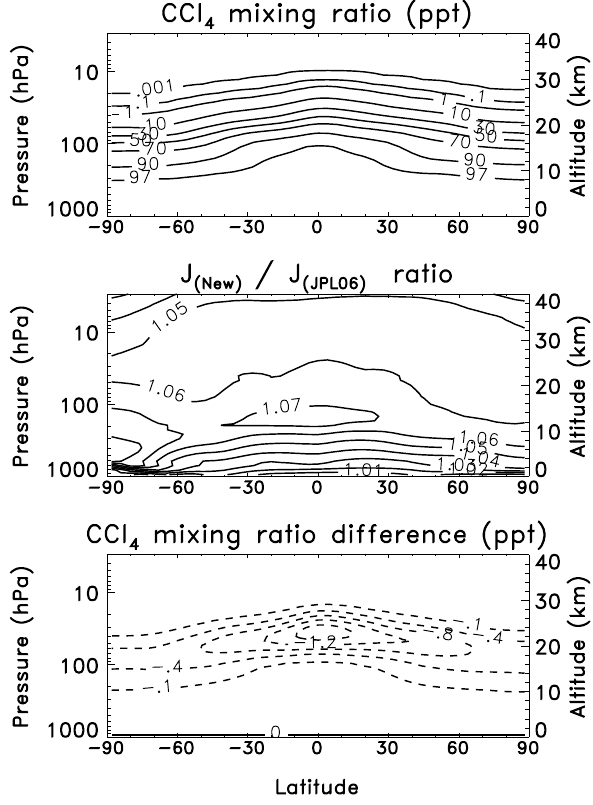
Fig. 5. (Top) Modeled distribution of CCl 4 mixing ratio (ppt); (mid- dle) ratio of the photolysis loss of CCl 4 using UV absorption cross sections obtained in this work to that using absorption cross sections from JPL06-2 (Sander et al., 2006); (bottom) modeled CCl 4 mix- ing ratio difference (ppt) using absorption cross sections obtained in this work and that using absorption cross sections from JPL06-2. All values are annual averages for year 2000. The contours plotted in the bottom panel are − .1, − ,4, − .8, − 1.2, and −